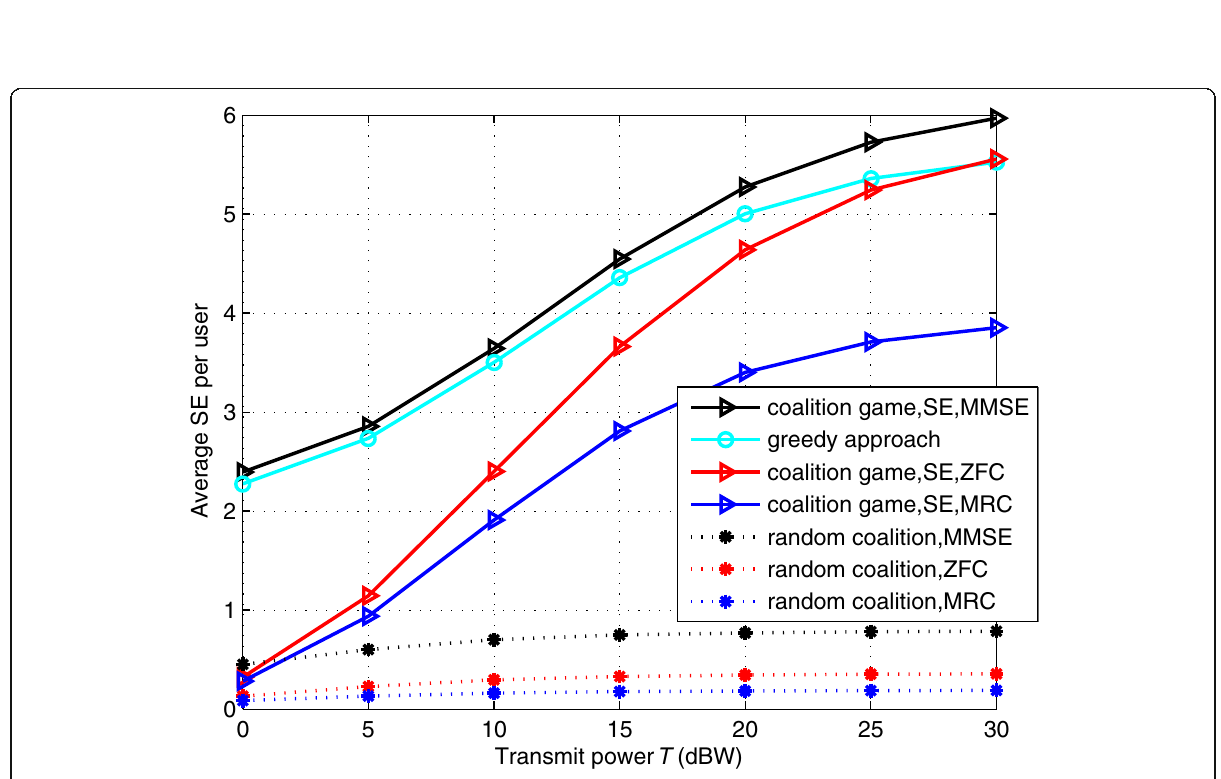
Fig. 9 Average spectrum efficiency (SE) versus transmit power T with P =